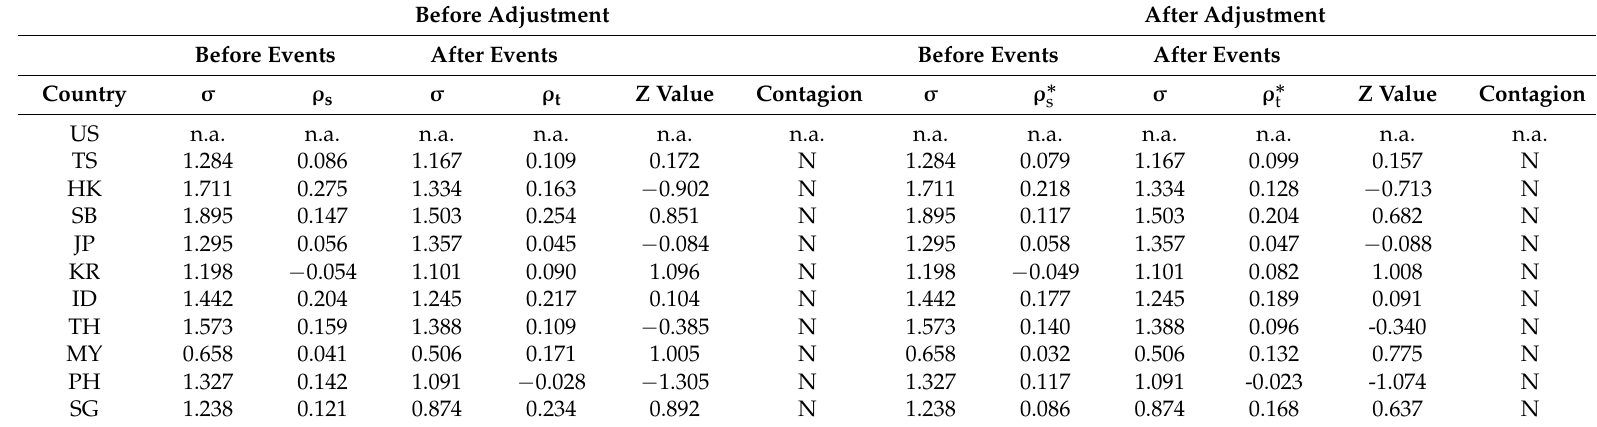
Table 10. The Correlation Coefficients after heteroscedasticity biases adjustment: European debt crisis. Before Adjustment After